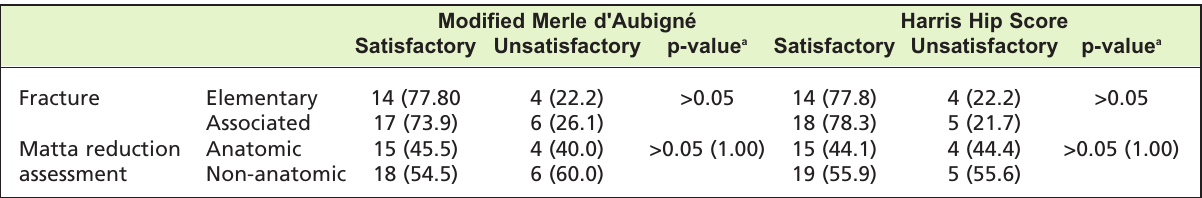
Association between acetabular fracture pattern and Matta radiological outcome with functional outcome Modified Table II: Merle d'Aubigné-Postel and Harris Hip score